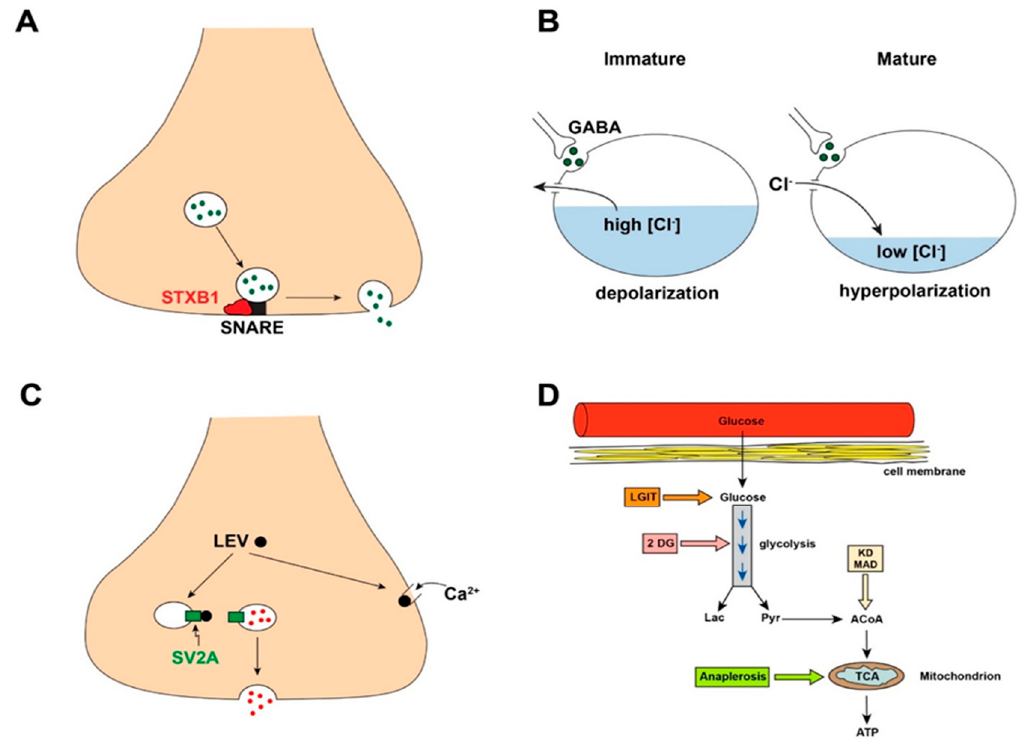
Figure 2. Selected examples of epilepsy mechanisms in which the E/I balance concept may not be immediately applicable. ( A ) STXBP1 is a protein essential for neurotransmitter vesicle docking and fusion to enable subsequent release of neurotransmitter. This protein binds to the soluble N-ethylmaleimide attachment receptor (SNARE) complex (see text) to allow neurotransmitter release. Mutation of the gene that encodes STXBP1 ( STXBP1 ) impairs neurotransmitter release (both excitatory and inhibitory neurotransmitters) and leads to a syndrome of neurodevelopmental disorder and severe epilepsy. ( B ) Early in development, GABA is excitatory rather than inhibitory, related in part to age-specific intracellular chloride concentrations. ( C ) The antiseizure drug levetiracetam (LEV) binds to a synaptic vesicle protein called SV2A, leading to reduced vesicle docking and neurotransmitter release. LEV also inhibits presynaptic N-type calcium channels and release of calcium from intracellular stores. ( D ) Overview of glucose (Gluc) metabolism. Glucose enters the cell from the bloodstream and then undergoes glycolysis for the eventual production of ATP. Metabolic control points for potential epilepsy therapy are indicated in the boxes. STXBP1, syntaxin-binding protein 1; LGIT, low glycemic index treatment; 2DG, 2-deoxyglucose; KD, ketogenic diet; MAD, modified Atkins diet; ATP, adenosine triphosphate; TCA, tricarboxylic acid cycle; ACoA, acetyl-co-enzyme A; Lac, lactate; Pyr, pyruvate.